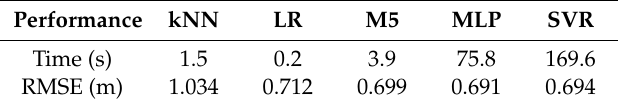
Table 3. Average performance of RMSE and computational time of four PCA cases on five models.